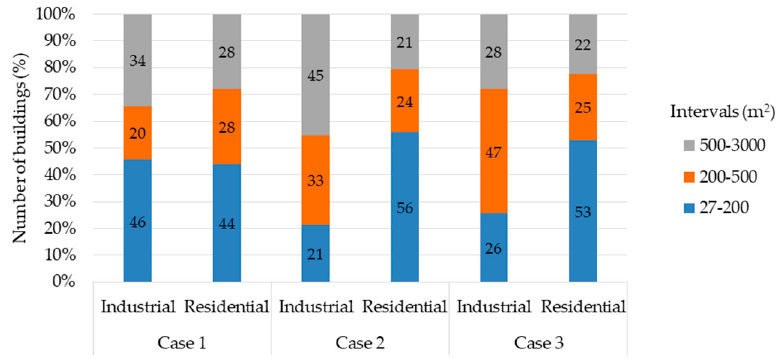
Remote Sens. 2020 , 12 , x FOR PEER REVIEW Figure 5. Projected area of reference: area distribution of the di ff erent cases of study. Figure 5. Projected area of reference: area distribution of the different cases of study.